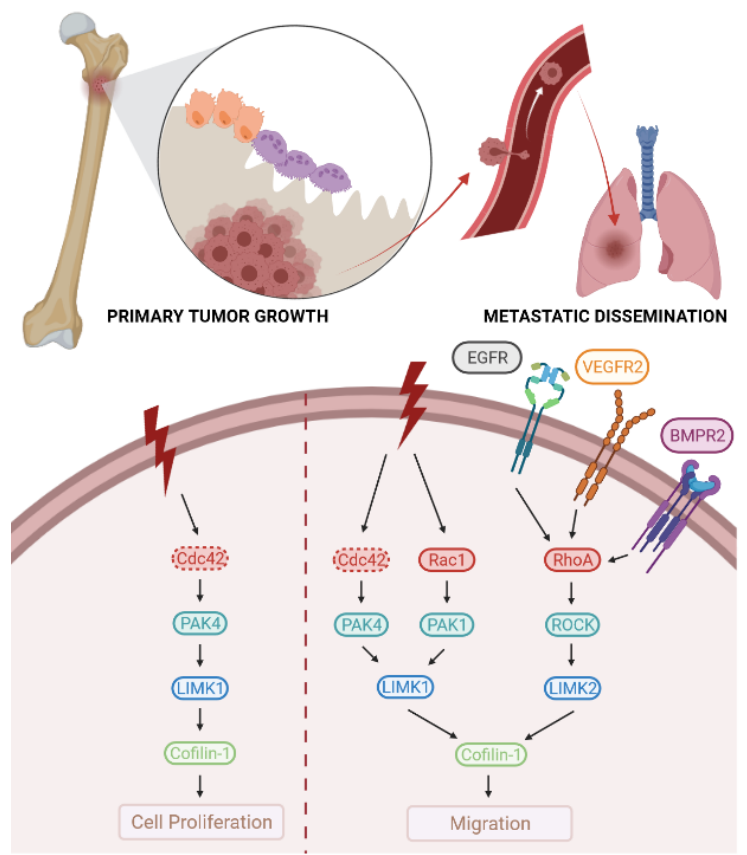
Figure 3. LIMKs and osteosarcoma. LIMK1 regulates the ability of osteosarcoma cells to proliferate and migrate, and thus participates in the control of primary tumour growth and metastatic development. LIMK2 preferentially regulates the ability of osteosarcoma cells to migrate and thus participates in the control of metastatic development.